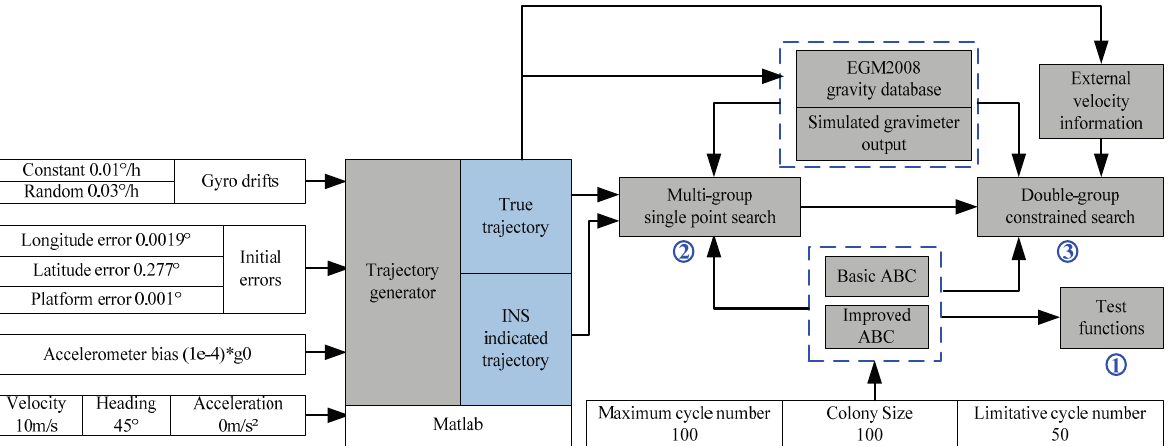
Figure 10. Flowchart of simulation experiment.